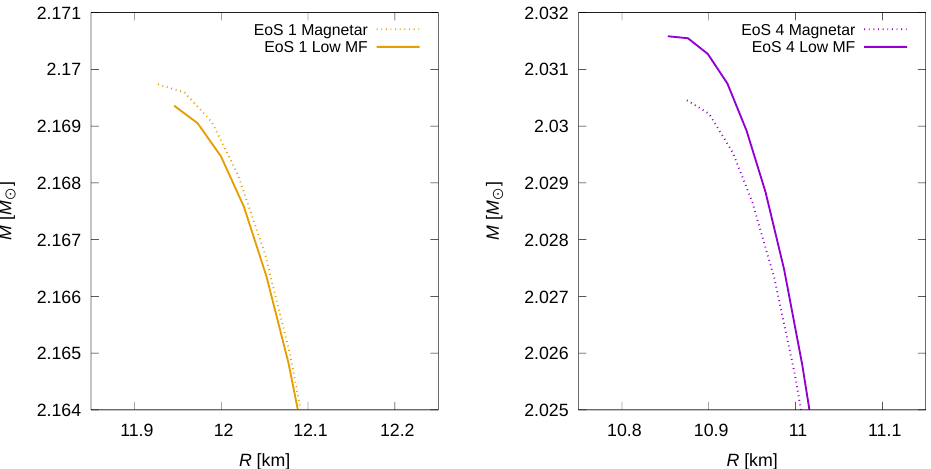
Figure 6. Enlarged zoomed-in view of the mass–radius relationships for the sets of Table 2. Contin- uous (dotted) curves represent low-MF (magnetars) QSs. It can be seen that the effect of the MF is negligible. Besides, a higher MF does not imply necessarily a higher value for M max . QS families constructed using EoSs 1 and 4 are more sensitive to the variation of the MF